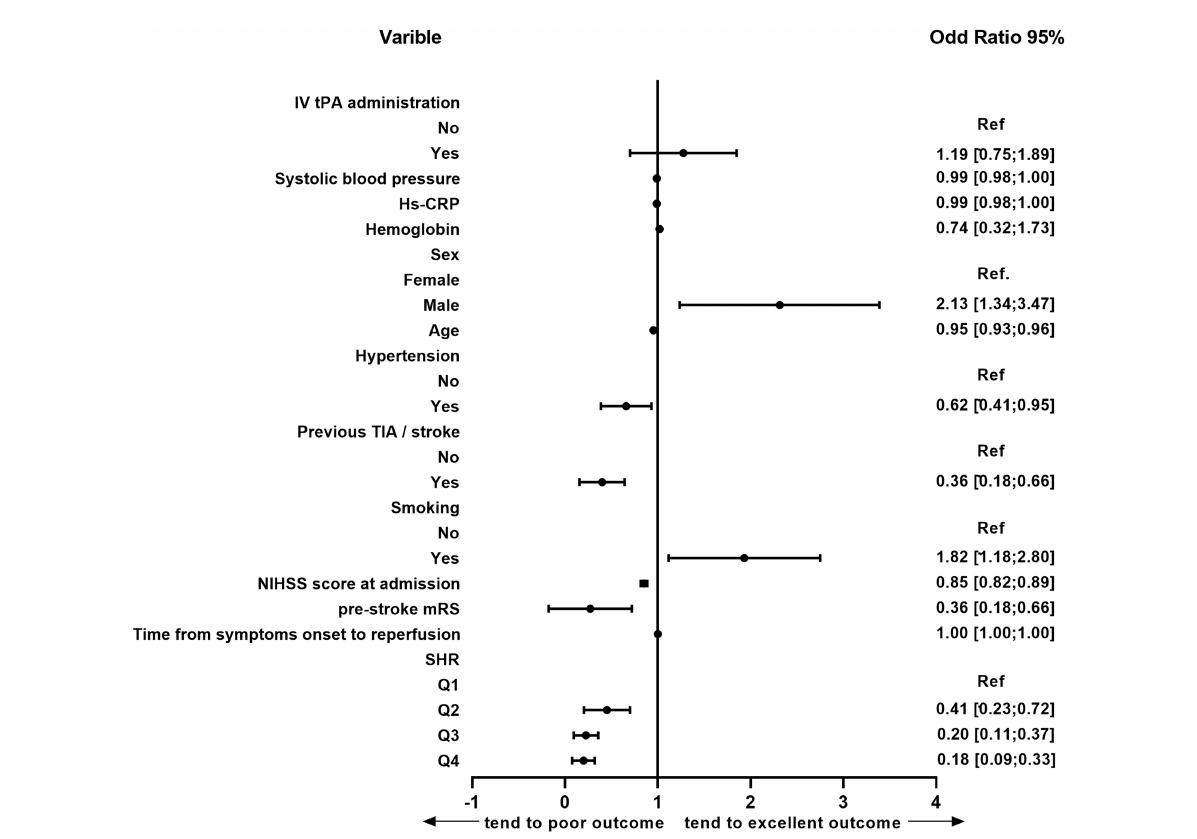
FIGURE 2 Multivariate logistic analysis of the risk factors for 3-month excellent outcomes in the following etiologies: age, sex, previous TIA/stroke, history of hypertension, smoking, hemoglobin, hs-CRP, systolic blood pressure, NIHSS score at admission, pre-stroke mRS, IV tPA administration and SHR. TIA, transient ischemic attack; NIHSS, National Institutes of Health Stroke Scale; SHR, stress hyperglycemia; hs-CRP, high-sensitive C-reactive protein; IV tPA, intravenous tissue plasminogen activator; CI, confidence interval; Ref.,